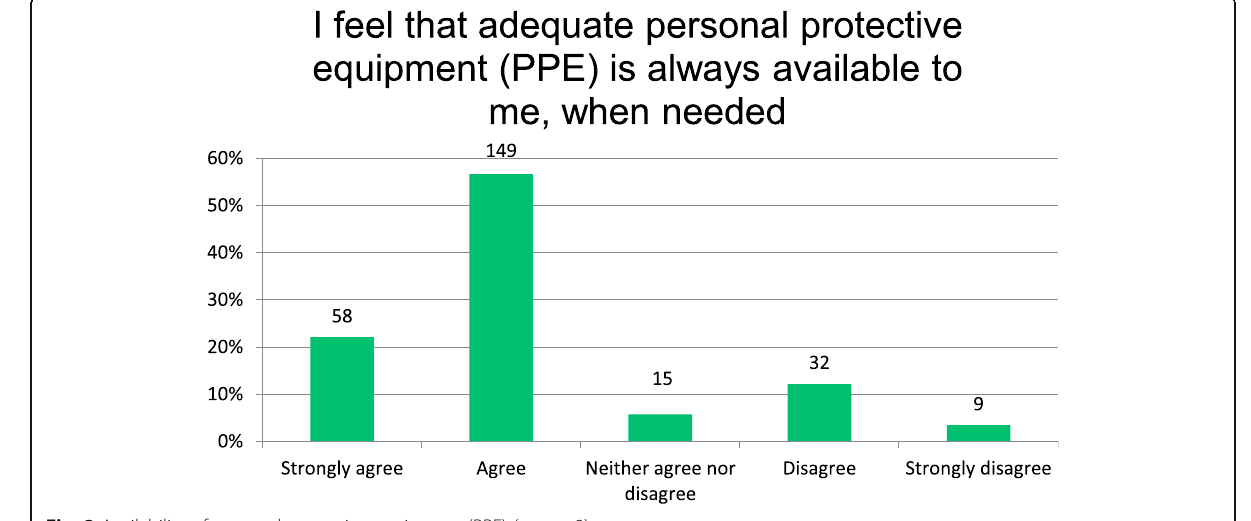
Fig. 3 Availability of personal protective equipment (PPE) (survey